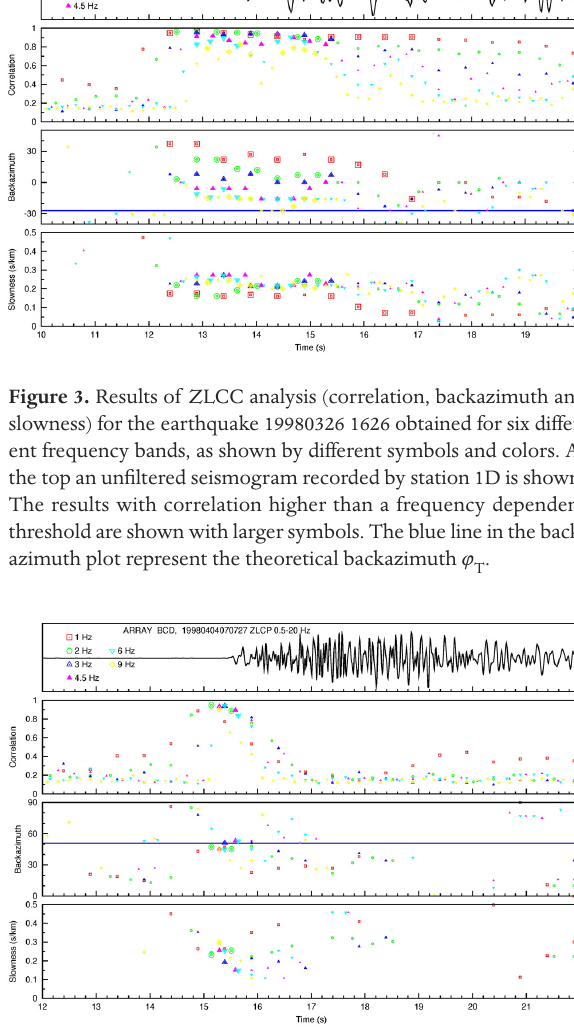
Figure 4. Results of ZLCC analysis (correlation, backazimuth and slowness) for the earthquake 19980404 0707. For this earthquake the correlation is greater the the chosen thresholds only for about one second at the beginning. Note that the correlation appears shifted to the left with respect to the seismic signal due to the slid- ing window length.